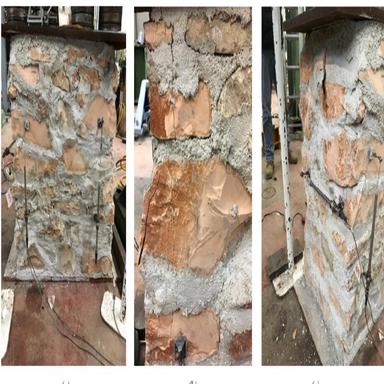
Wall matrix with displacement transducers installed (a), and the damage at the end of the compression test (b,c).